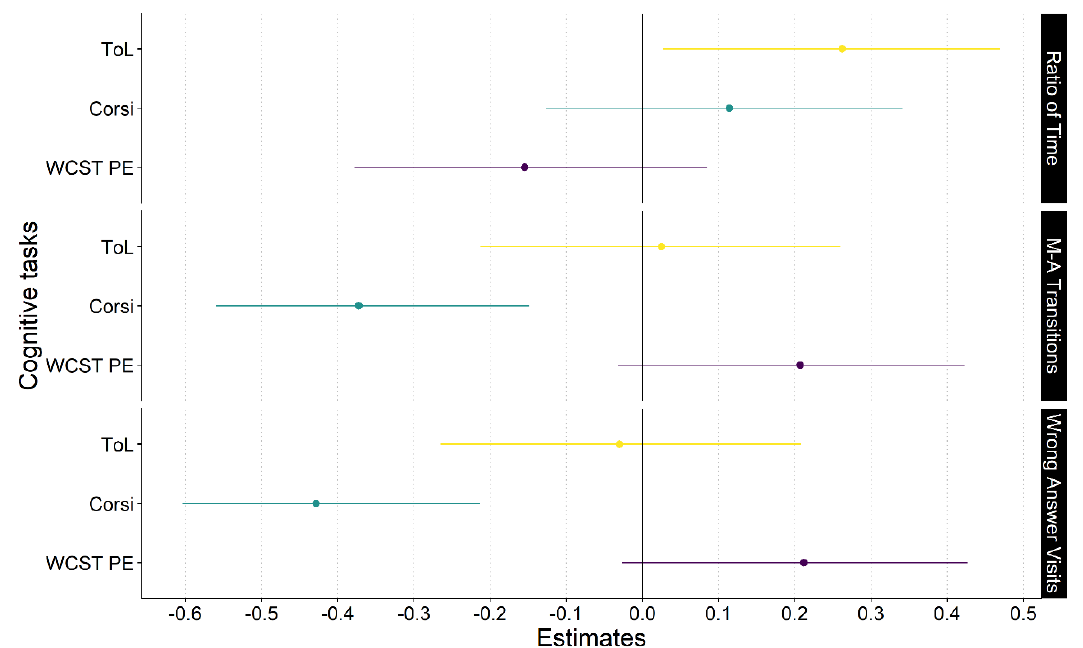
Figure 5. Forest plot presenting the correlation estimates and their 95% confidence interval for the correlation between the select eye gaze metrics and performance on cognitive tasks. The colors of the lines and dots are related to each cognitive test. Note: ratio of time: ratio of time spent on the matrix vs. answer; M-A Transitions: matrix–answer transitions; ToL: Tower of London test; Corsi: Corsi block-tapping test; WCST PE: Wisconsin Card-Sorting Test Perseverative Errors.